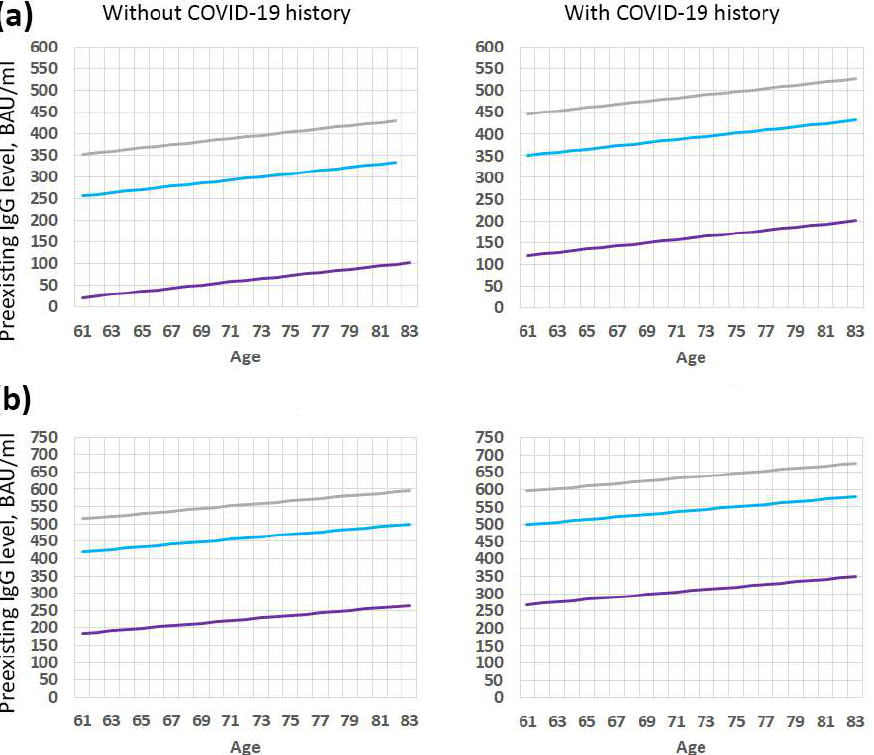
Figure 4. Threshold level of antibodies before the start of revaccination, at which (and below) an antibodies ratio will be predicted at least 1.5 (gray), 2 (blue), or 4 (purple) times after the introduction of the first (RV1) ( a ) or second (RV2) ( b ) jab during revaccination.